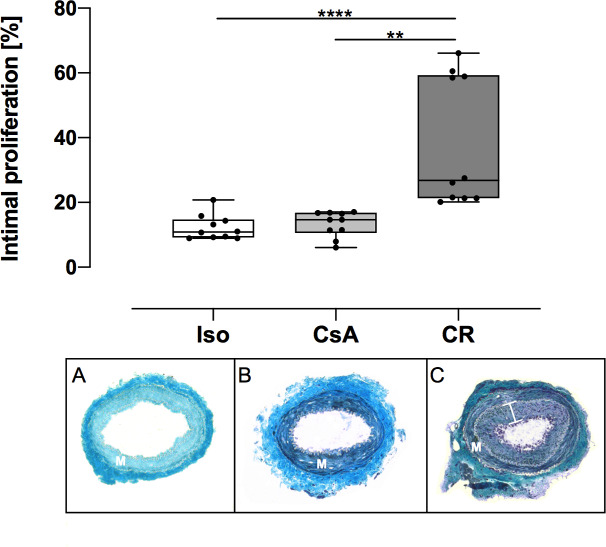
Intimial proliferation in femoral arteries at POD 100 in percent.Above: Data is presented as individual data points and boxplots; boxplots show the median, 25%- and 75%-quartile; whiskers indicate the minimum and maximum. In the CR group, the femoral artery showed a significantly elevated intimal proliferation rate in comparison to Iso and CsA group, as indicated (**: p < 0.01; ****: p < 0.0001). Below: Representative images of Iso (A), CsA (B) and CR (C) group, Masson's trichrome stain at 10x. Intimal proliferation and luminal occlusion is seen in the femoral artery of the CR group (M: media; bracket indicates the CR group intima).